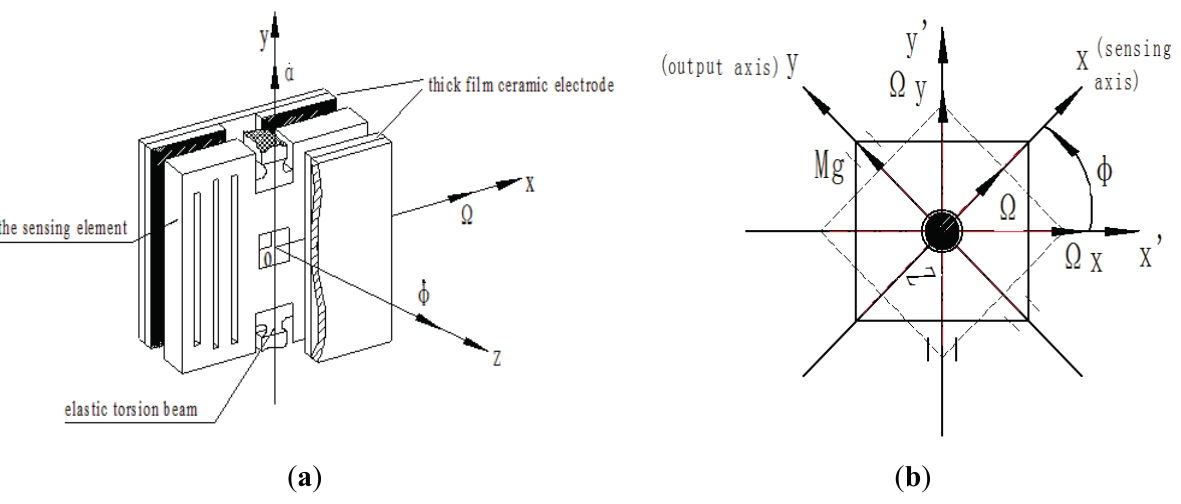
Figure 4. ( a ) The structural diagram of the gyro; ( b ) The diagram of the working